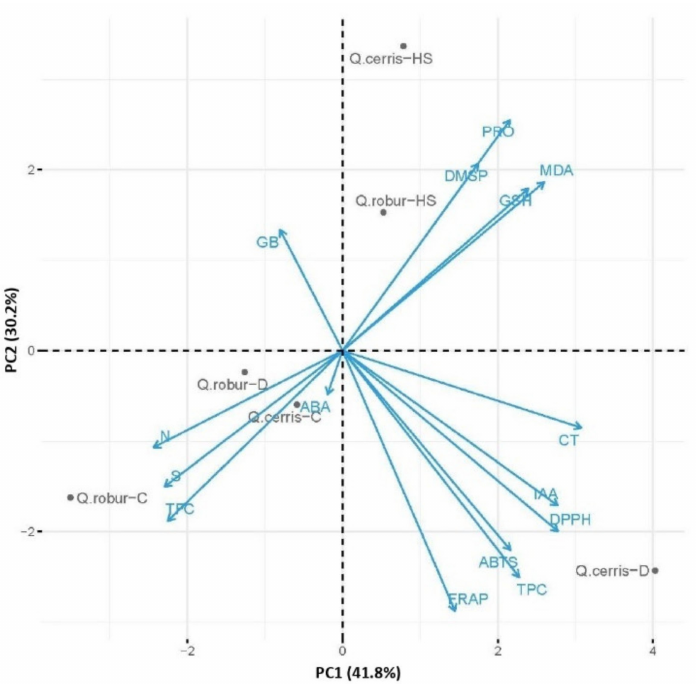
Figure 6. Principal component analysis (PCA) on a correlation matrix including all the biochemical parameters for control I drought-stressed (D) and high-temperatures-stressed (HS) plants of Quercus cerris (Q. cerris) and Quercus robur (Q. robur). TPC: total phenolic content; TFC: total